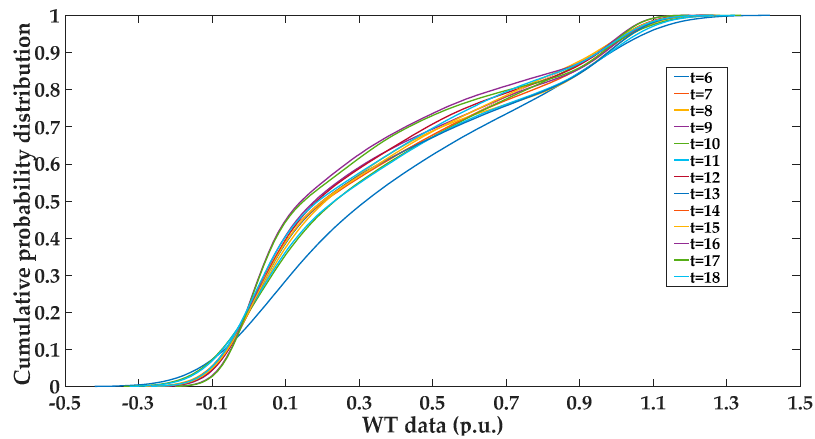
Figure 5. Cumulative probability functions of WT data during the times of t=6-18.